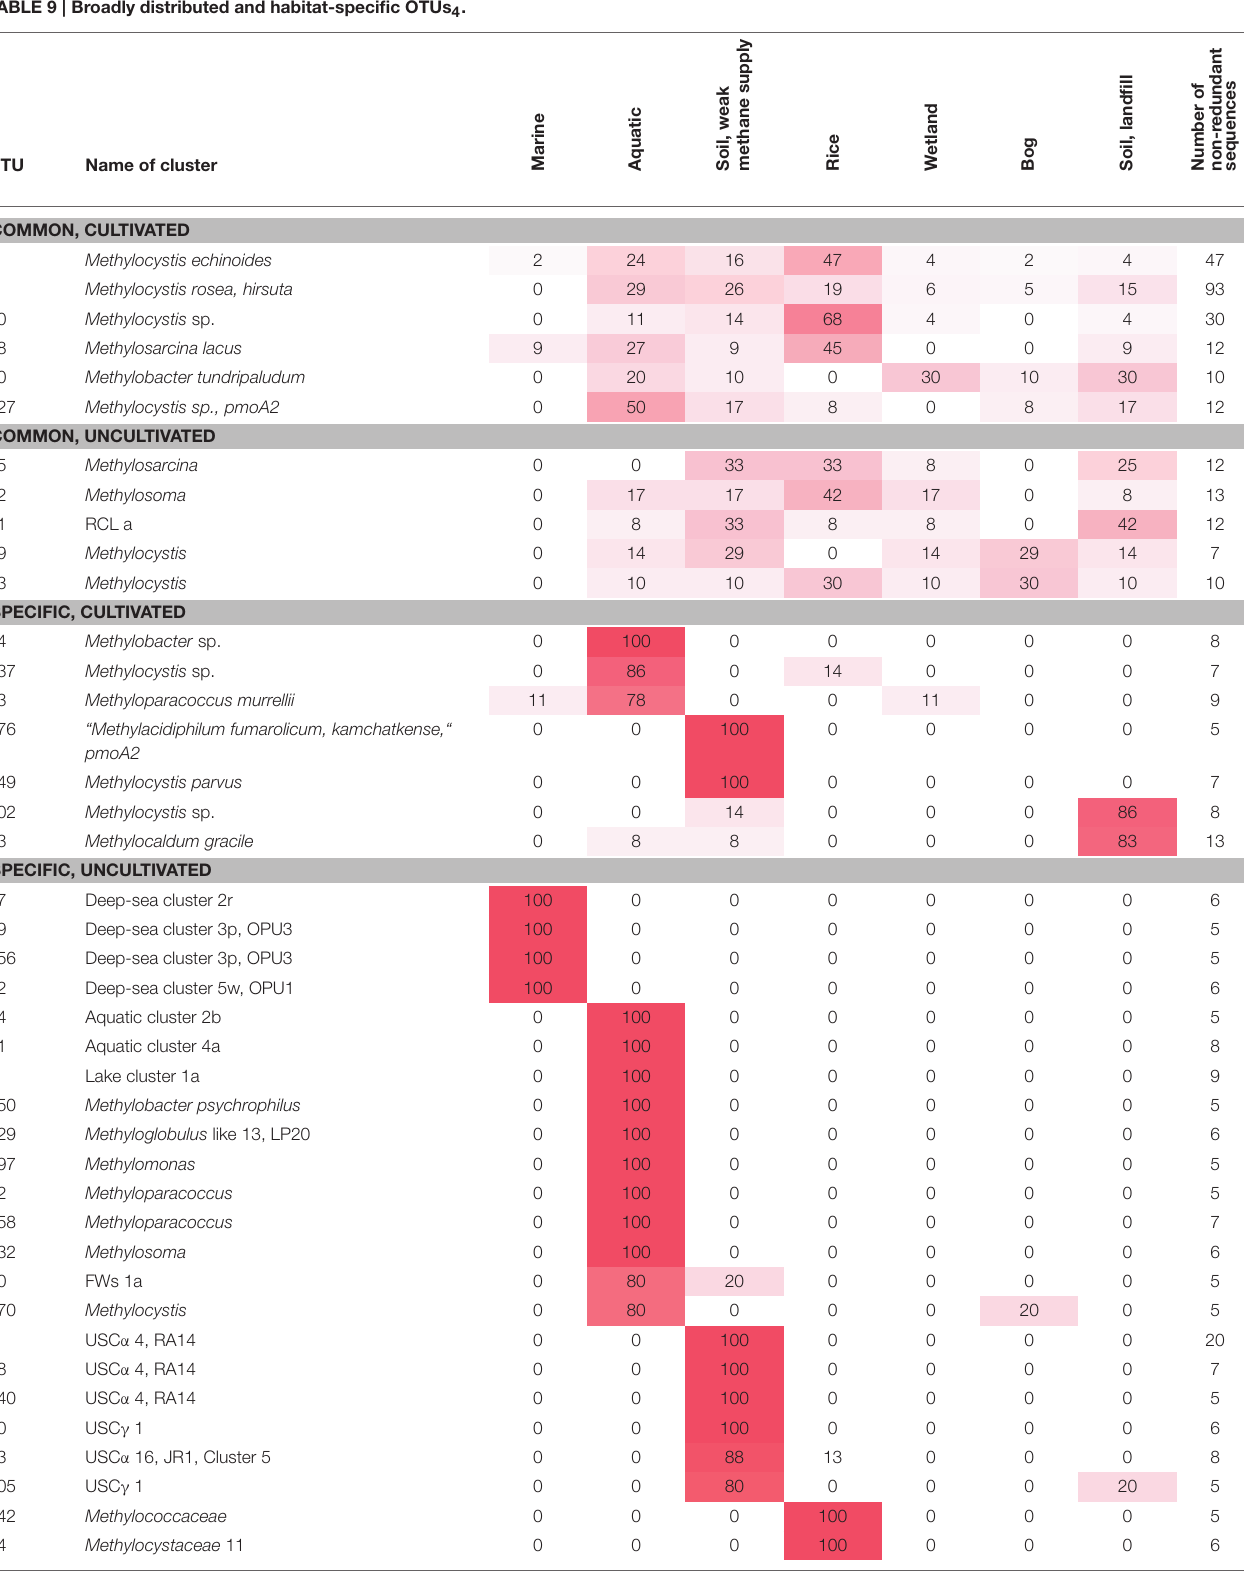
TABLE 9 | Broadly distributed and habitat-specific OTUs 4